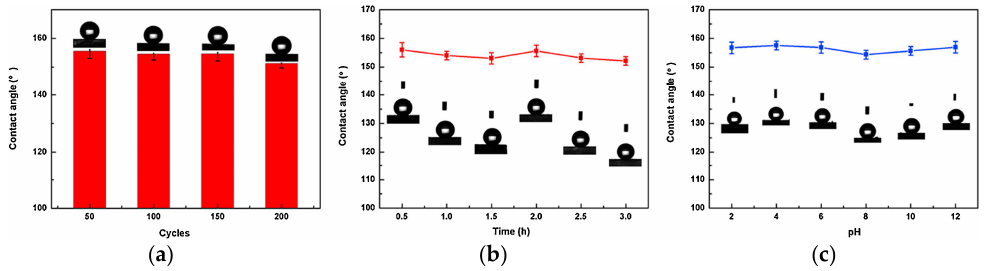
Figure 6. Stability tests of superhydrophobic coatings. ( a ) Mechanical stability of coatings with abrasion cycles under 250 kPa; ( b ) effect of ultrasonication time on the water contact angles of the coating; ( c ) water contact angle of the coating after immersed on aqueous solution of pH 2–12 for 12 h. Reprinted from [68] with permission; Copyright Elsevier 2016.